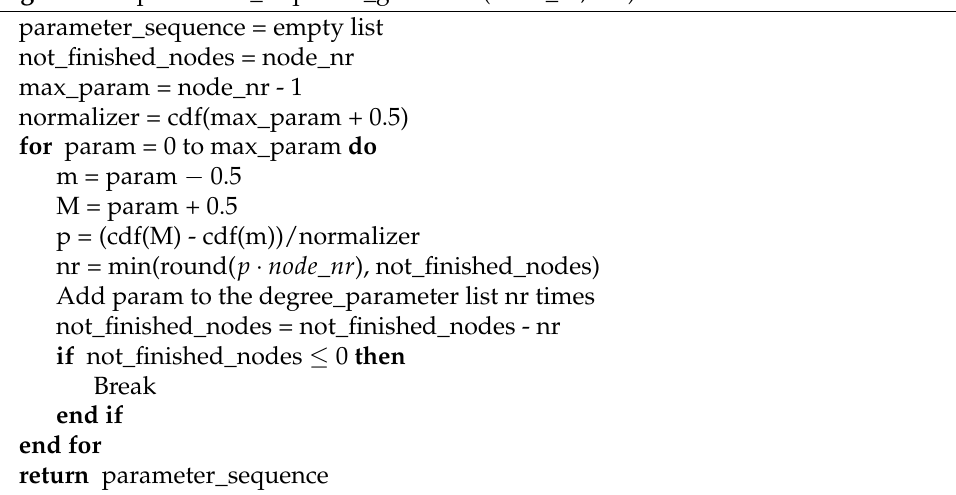
Algorithm 5 parameter_sequence_generator(node_nr,